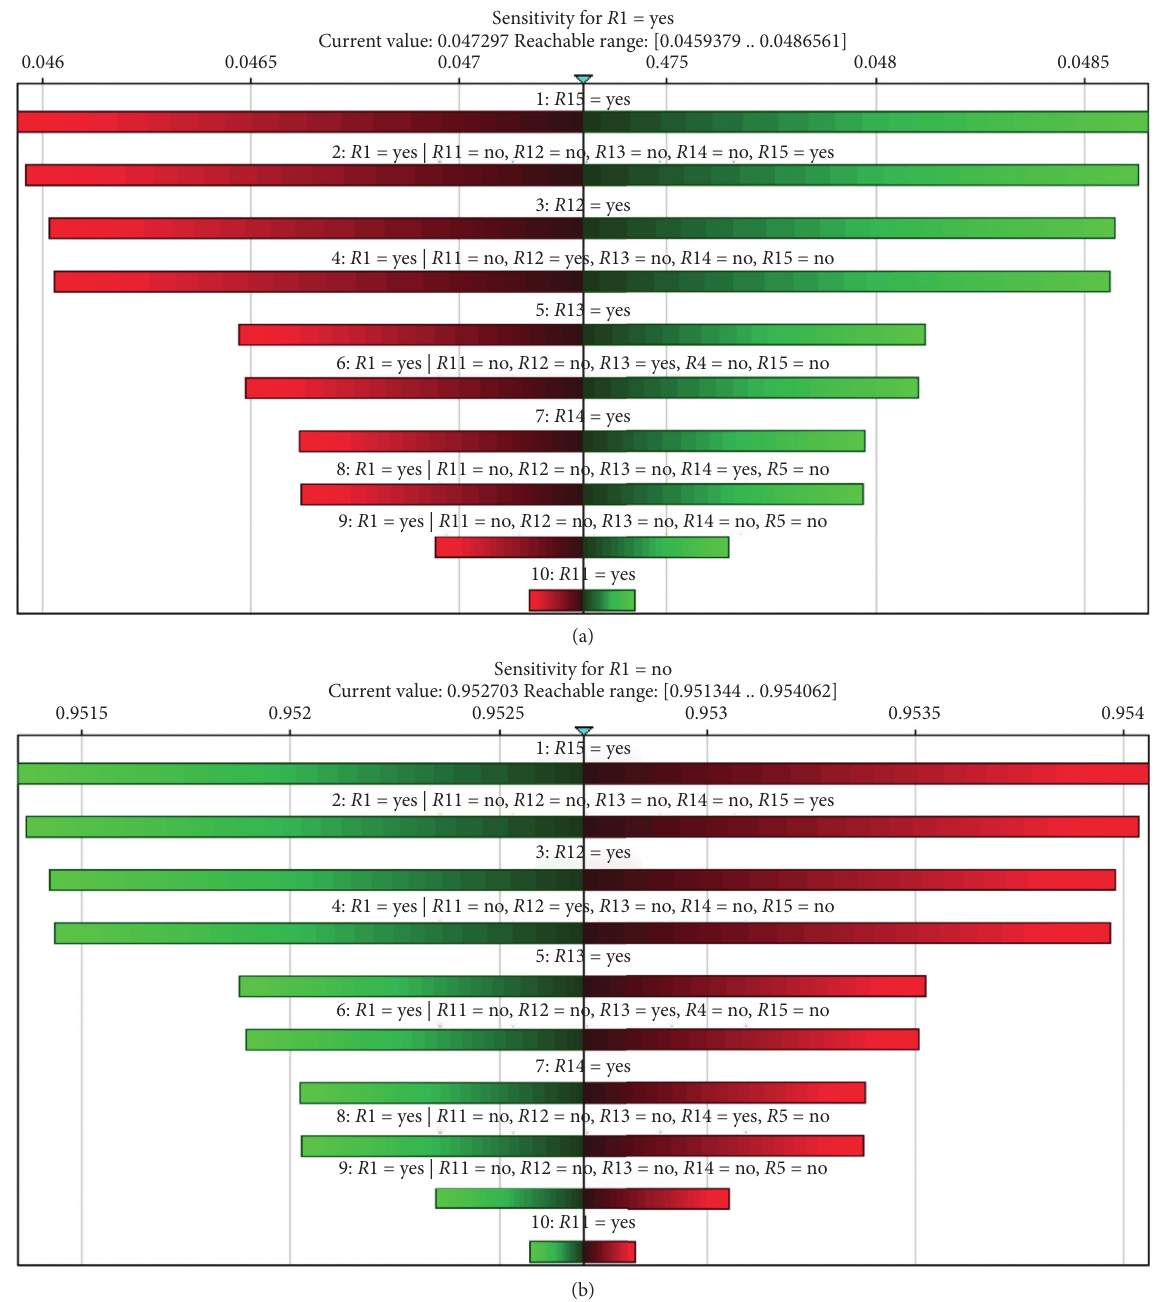
Figure 6: Sensitivity analysis of “human resource risk ( R 1).” (a) R 1 � “yes” state. (b) R 1 � “no”